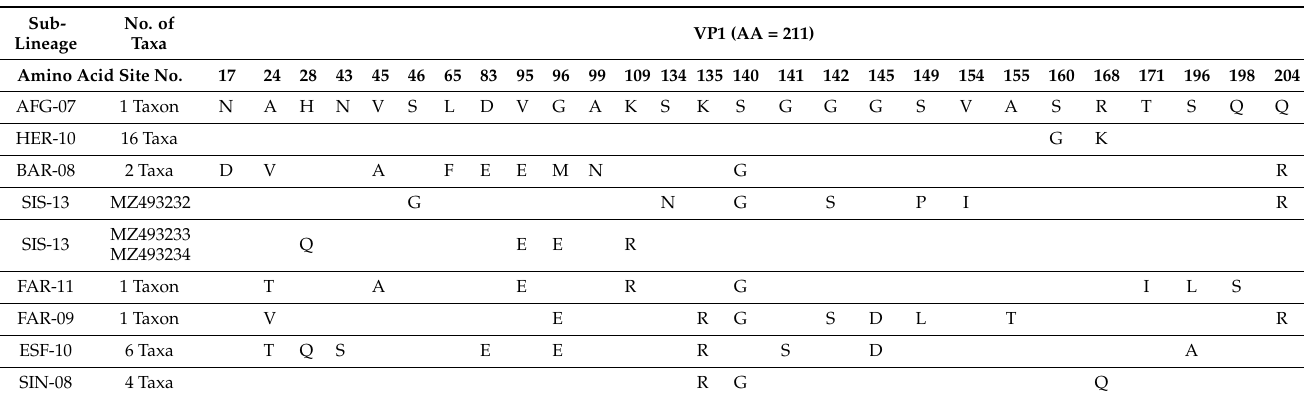
Table 2. A comparison of non-synonymous amino acid substitutions in capsid protein VP1 of eight sub-lineages of